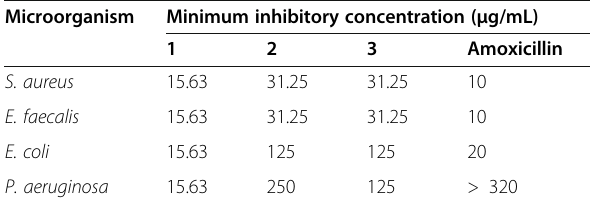
Table 1 Phytochemical screening of the stem bark of A. genipiflora